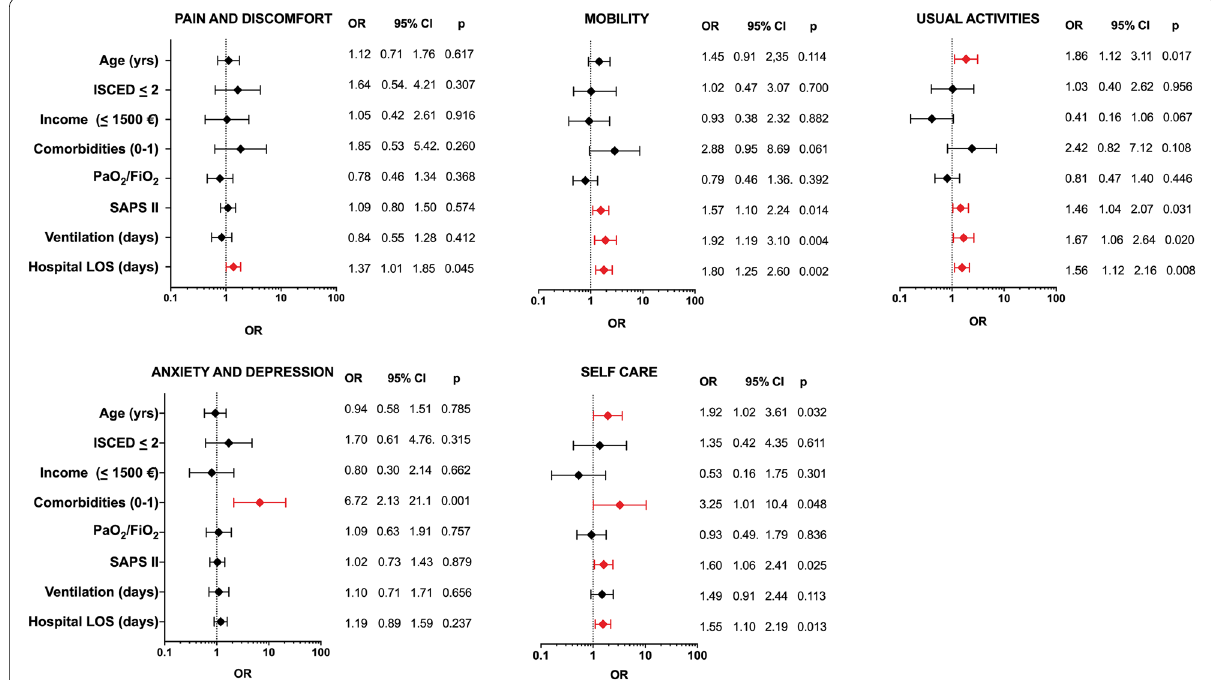
Fig. 3 Univariate analysis of demographics, socio-economic, and clinical factors associated with impaired health-related quality of life (EQ-5D-5L) in C-ARDS survivors. The figure shows the results of the univariate analysis of factors associated with problems (of any severity) in each of the five EQ-5D-5L domains (dependent variable) and the correspondent forest plots. In red, variables significantly associated with the development of problems in each single domain. Reference value for the dependent variable: no problems vs any problems. Covariate values are on the y-axis, with reference values and/or unit of measure, when applicable. Variables were transformed as follows: age/10, PaO 2 to FiO 2 /100, SAPS II/5, duration of mechanical ventilation (days)/10, and hospital LOS (days)/10. SAPS II, Simplified Acute Physiology Score; ventilation (days), duration of ventilation with PEEP 5 cmH 2 0; LOS, length of ≥